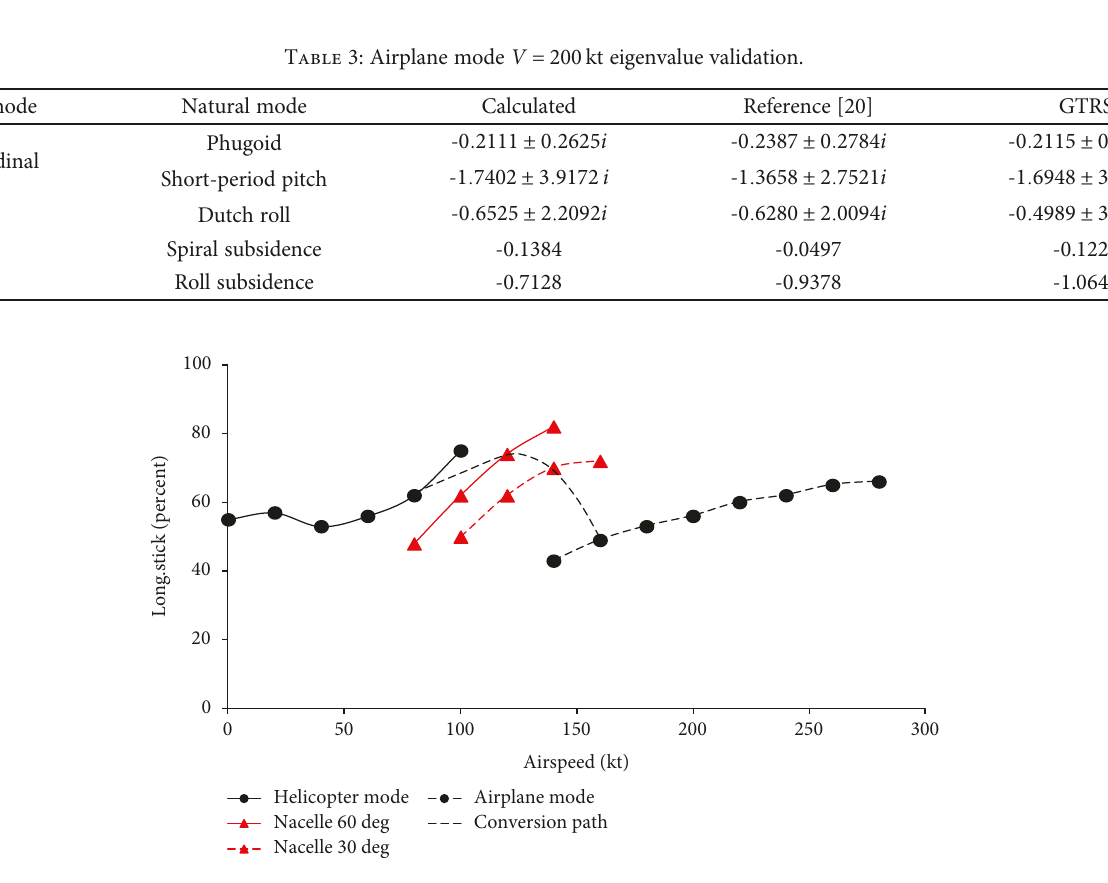
Figure 8: Longitudinal stick migration with respect to